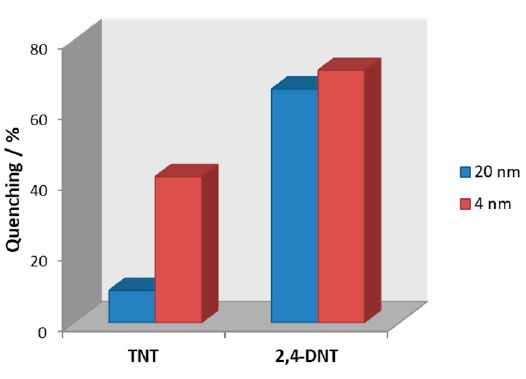
Figure 4. Effect of different thicknesses ( ≈ 4 nm and 20 nm) of Calix ‐ PPE ‐ 2,7 ‐ CBZ thin ‐ films on the fluorescence quenching responses to saturated TNT and 2,4 ‐ DNT vapours, upon 30 s exposure at 25 °C ( λ exc = 360 nm).